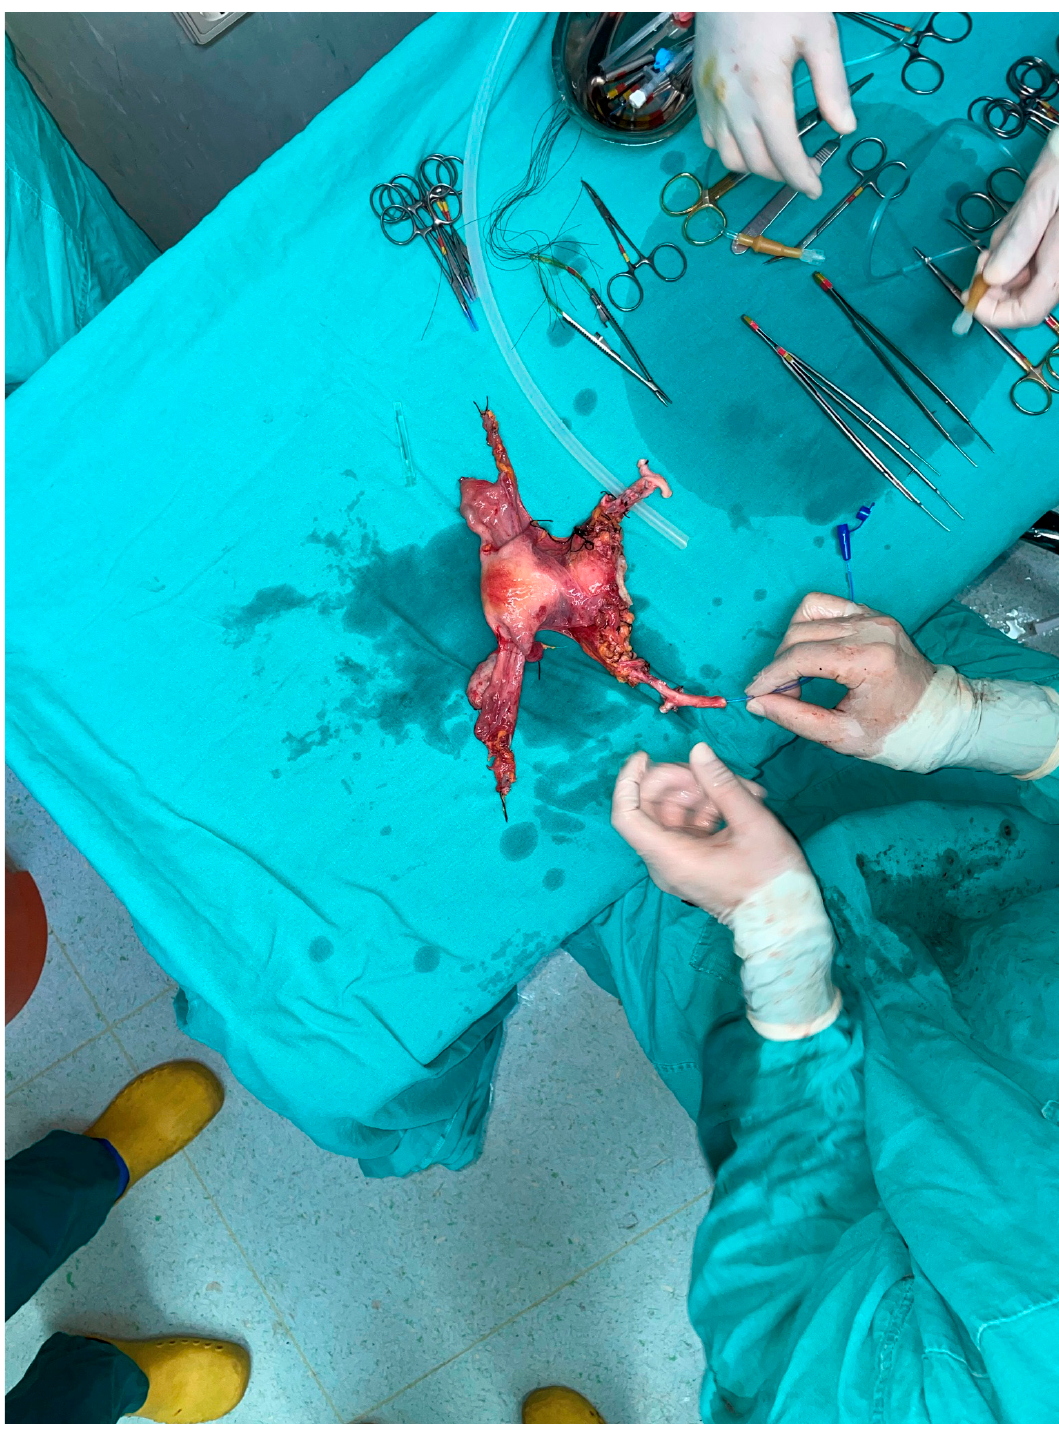
Figure 5. Uterine graft during back table preparation. Note the long vascular pedicles.